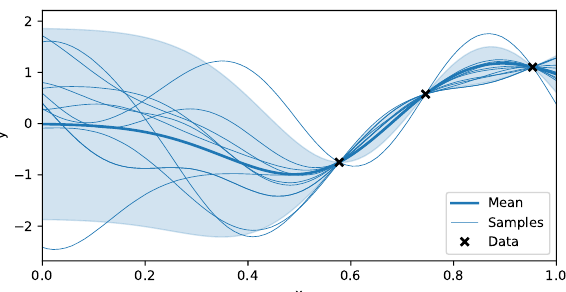
Figure 2. Predictions made by a Gaussian Process (GP). The data used to train the GP model are indicated with the black markers. The predictive distribution consists of a mean, indicated with the thick blue line, and a covariance of which the diagonal elements are used to calculate the 95% confidence interval plotted around it. Since the prediction consists of a correlated Gaussian, it is possible to sample from this distribution, as shown in the plot. Every one of those samples possibly match with the real, underlying